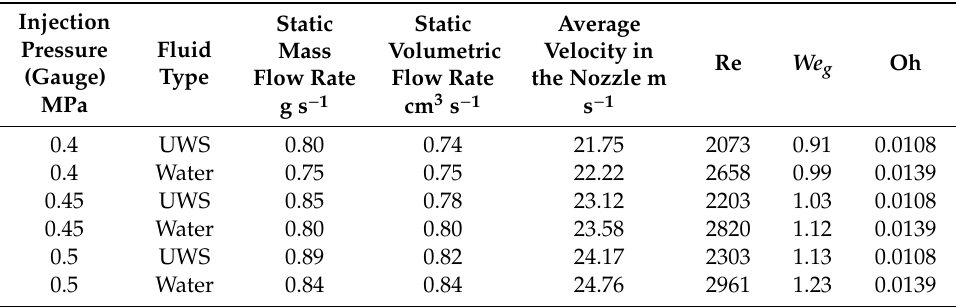
Table 2. In-injector flow